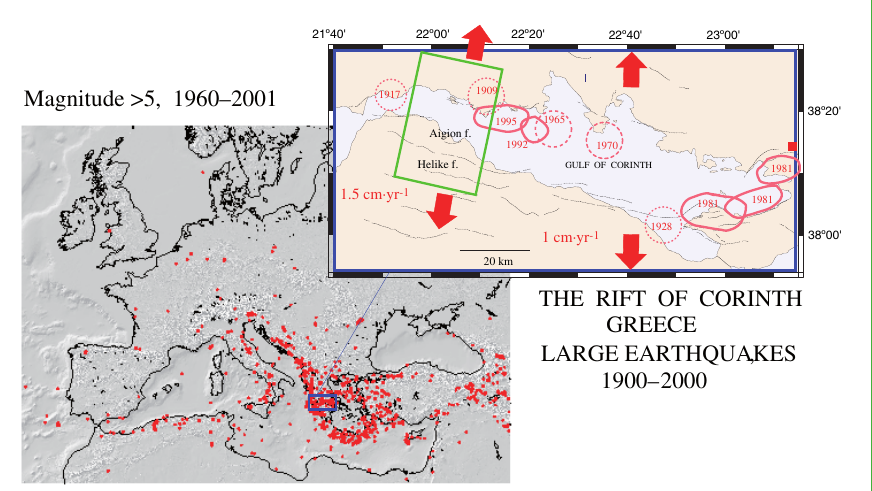
Figure 1. Geodynamic context of the Corinth Rift